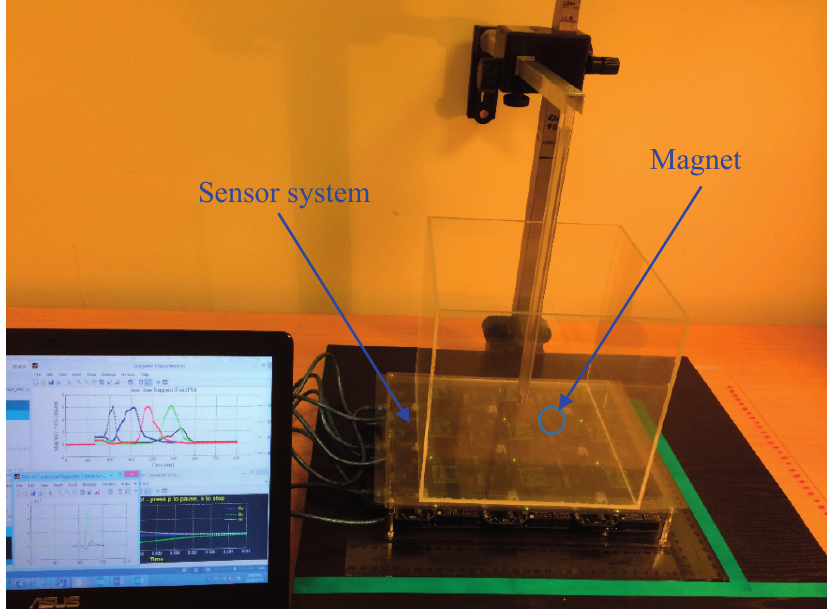
Figure 13. In vitro experimental